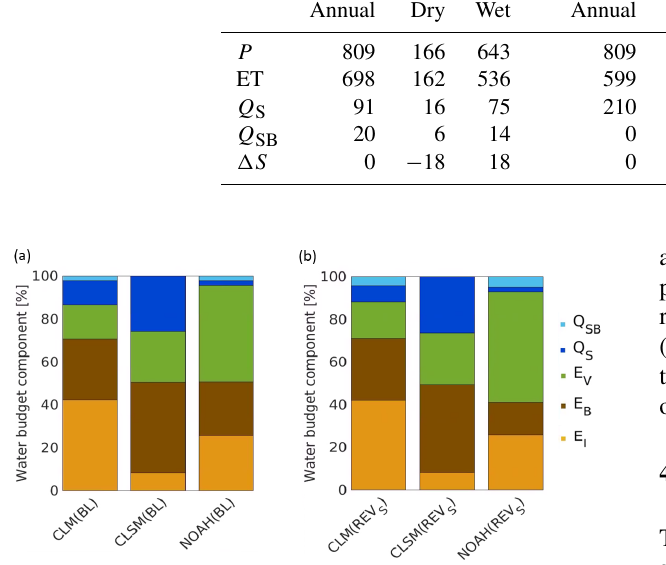
Figure 3. Long-term (1992–2015) annual water budget components averaged over the Dry Chaco relative to the total precipitation for the (a) BL and (b) REV S experiments ( Q SB : subsurface runoff, Q S : surface runoff, E V : vegetation transpiration, E B : bare soil evapora- tion, E I : interception